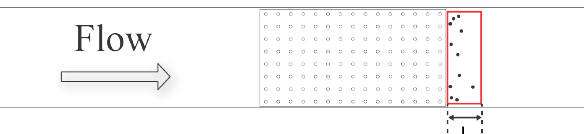
Figure 11. Sheltered region formed downstream of the macrophyte models. The red rectangle is a symbolic depiction of the sheltered region. This sheltered region begins at the downstream end of the macrophyte model and continuous downstream of the model. “L” is the length of the sheltered region, and it varies with the density and height of the macrophyte model.